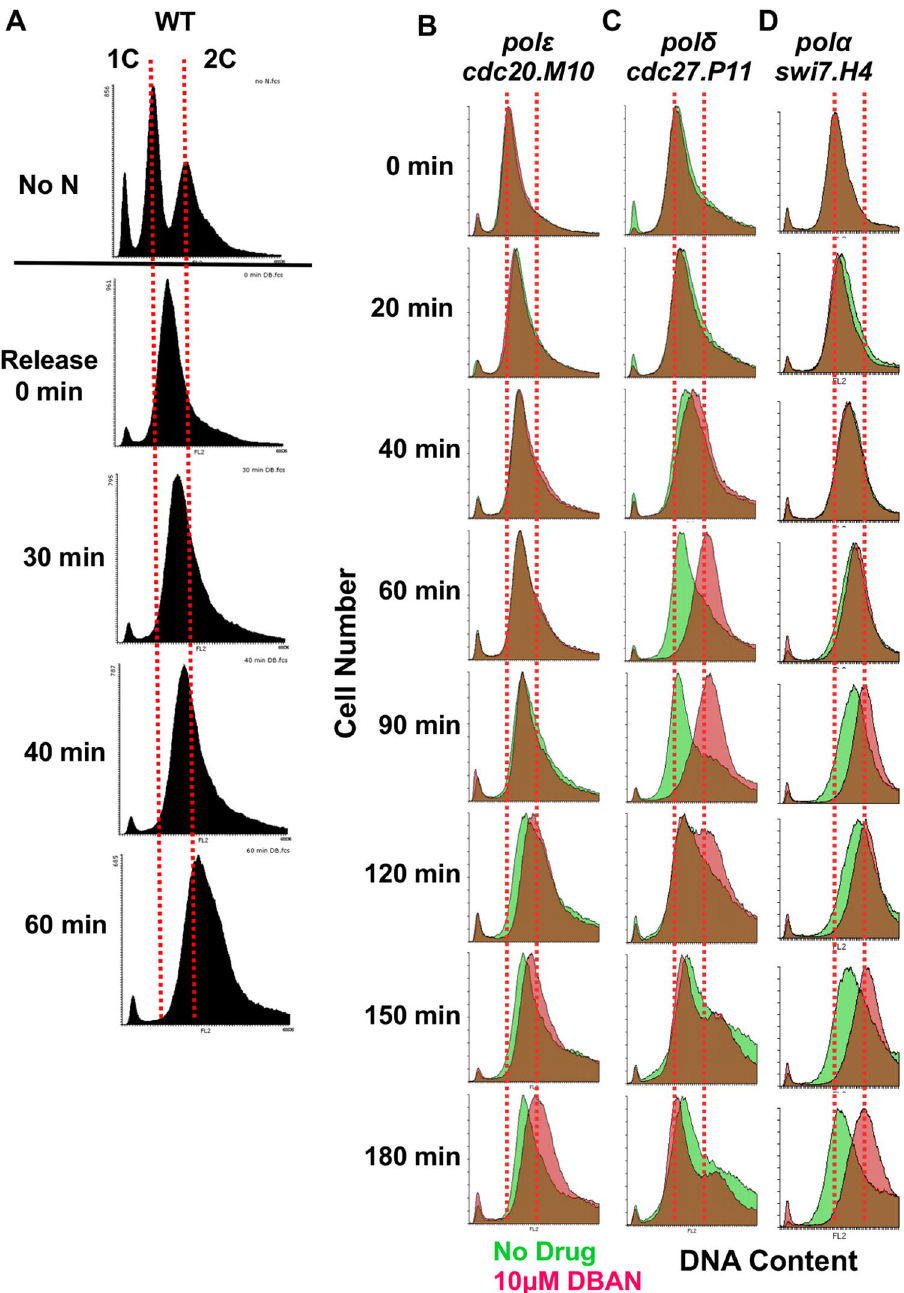
Figure 4. DBAN advances DNA replication in a pol delta mutant. ( A ) Wild type cells ( ade6-M210 leu1–32 ura4-D18 ) were grown in rich medium at 30 °C and synchronised in early S phase for 3.5 h in 15 mM hydroxyurea (HU) 29 . HU was washed out and cells were released into pre-warmed rich medium. The DNA content was measured at the indicated times. The dotted lines indicate 1 copy of the chromosomes (1 C, G1) and two copies (2 C, G2), respectively. The DNA content of nitrogen starved cells (no N) was measured in a parallel experiment to have an internal standard. ( B – D ). The indicated mutant strains were HU-synchronised and released into rich medium at 30 °C with or without 10 μ M DBAN. The green histogram is the DNA content of untreated cells, the red histogram is the DNA content in the presence of DBAN. The brown colour indicates that both histograms